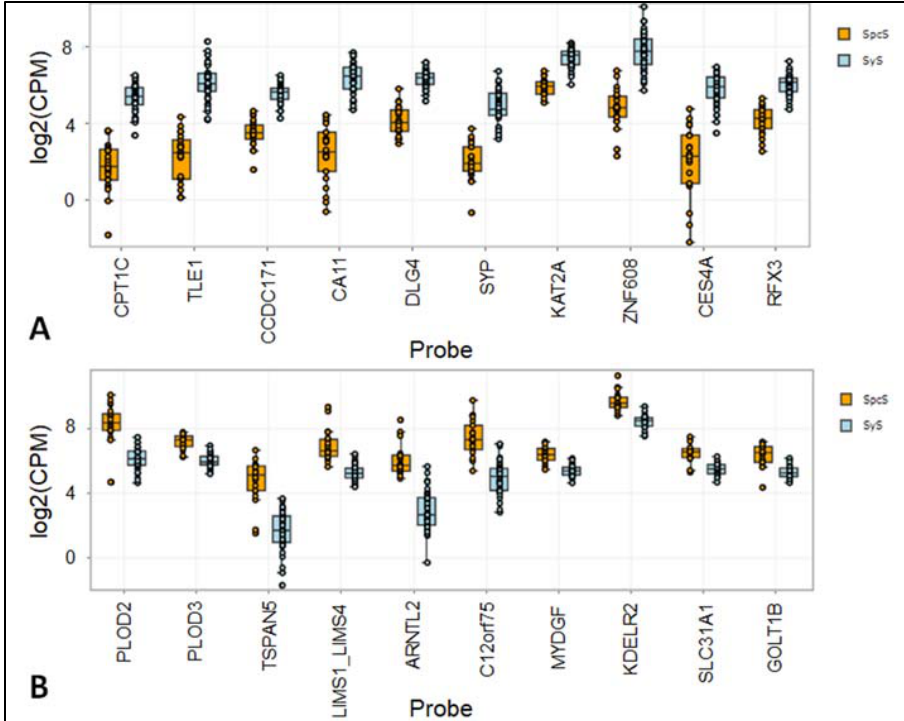
Figure 4. Differently expressed genes between SyS and SpcS. ( A ) Top 10 of the up ‐ regulated genes in SyS and ( B ) top 10 of the up ‐ regulated genes in SpcS are shown. Table 2. Data of the top 10 differentially expressed genes between SyS and SpcS. Mean normalized values for SyS and SpcS, average expression, fold change, raw p -value, and false-discovery-rate (FDR)-adjusted p -values are